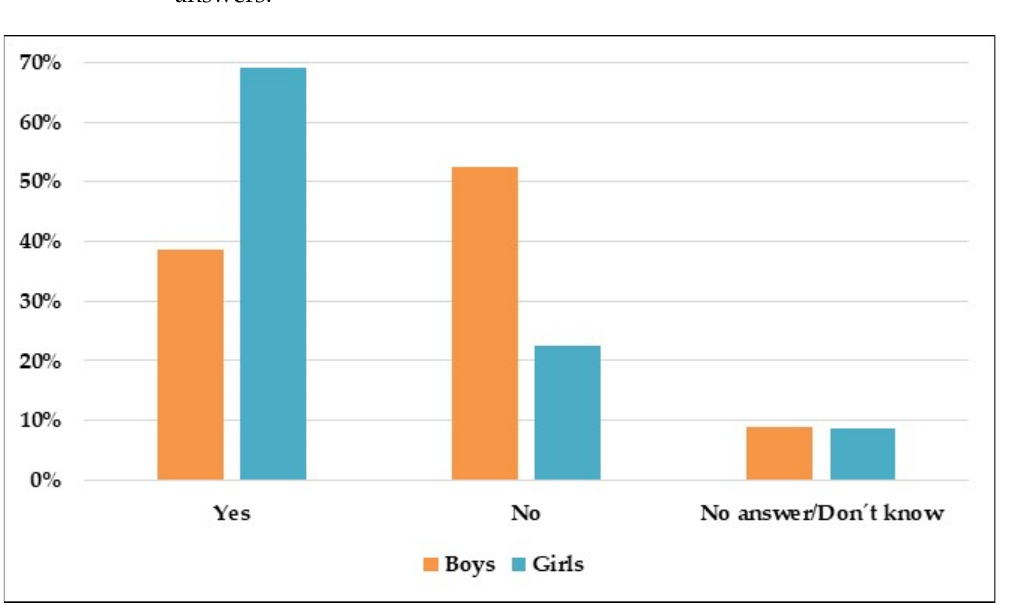
Figure 4. Existence of antecedents per gender.